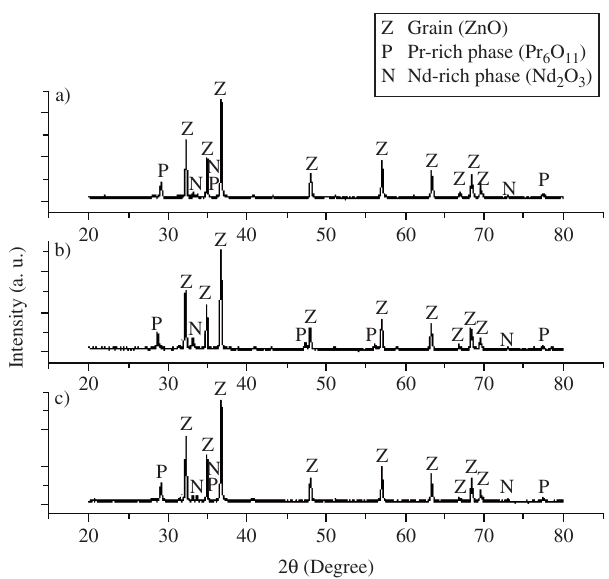
Figure 3. X-ray diffraction (XRD) patterns of ZPNC varistor ceramics: a) ZPNC-1; b) ZPNC-2; and c) ZPNC-3. Reference pattern codes for rare- earth oxides (PDF index name): 00-024-1006 (praseodymium oxide) and 00-043-1023 (neodymium oxide).